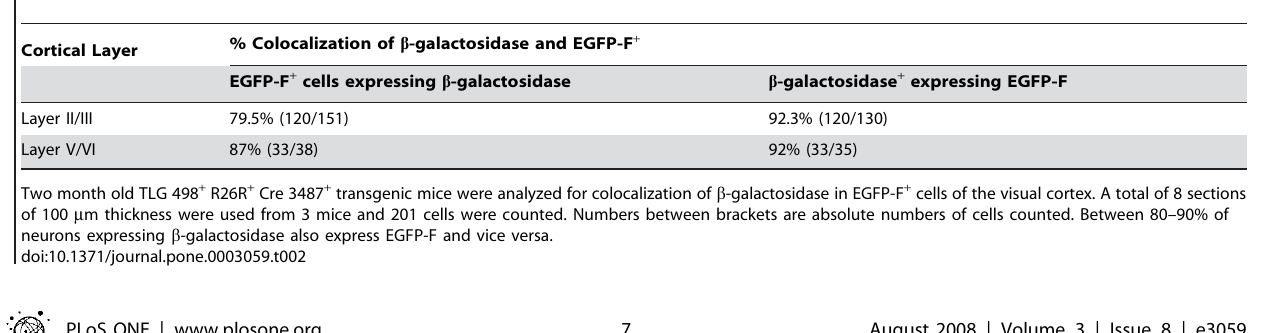
Table 2. Colocalization of EGFP-F and b -galactosidase in TLG 498 + R26R + Cre 3487 + mice.